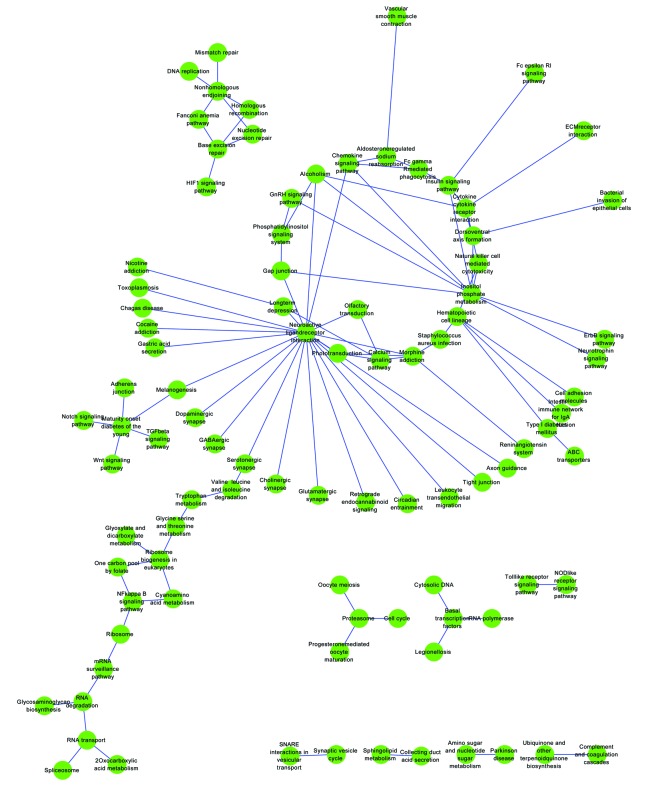
Co-change network for pathways in osteoporosis. The nodes and edges represent the pathways and pathway-pathway interactions, respectively.